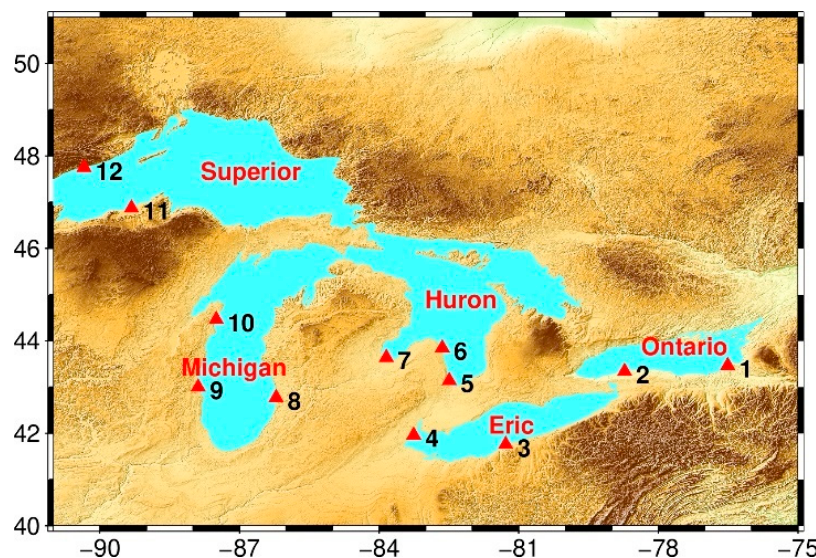
Figure 1. Location of water bodies and surface hydrological stations in the study area. Light blue areas are water bodies, and red triangles are locations of hydrological stations.